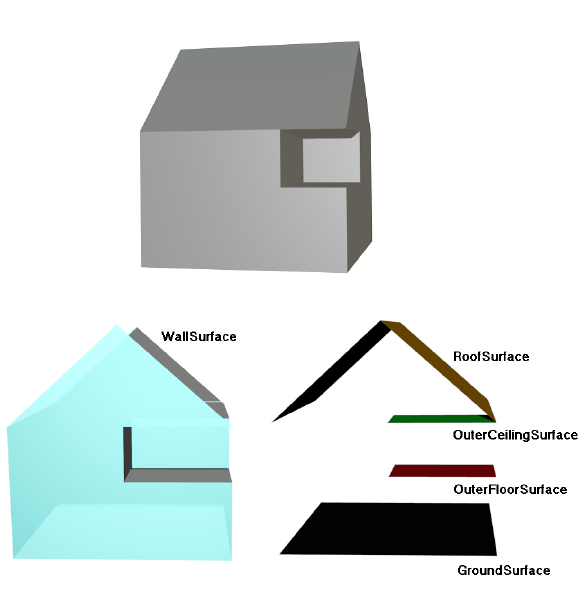
Figure 2: Semantic BoundarySurfaces classes of an LoD2 model in the CityGML